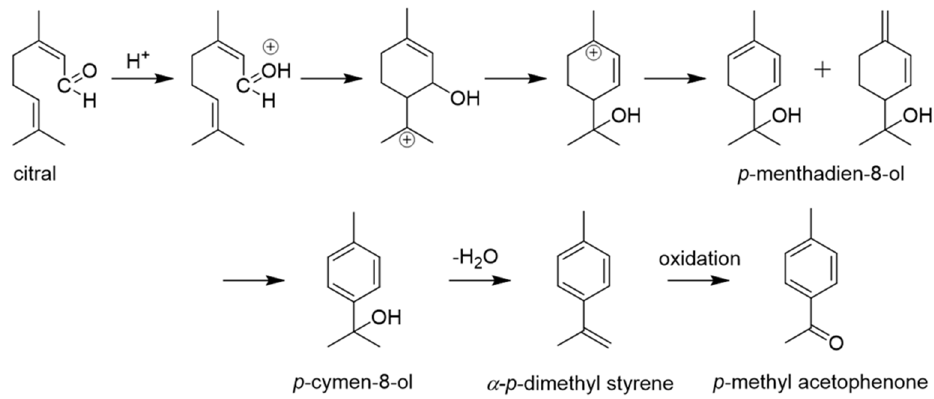
Figure 2. Formation route of deteriorated substances of citral.